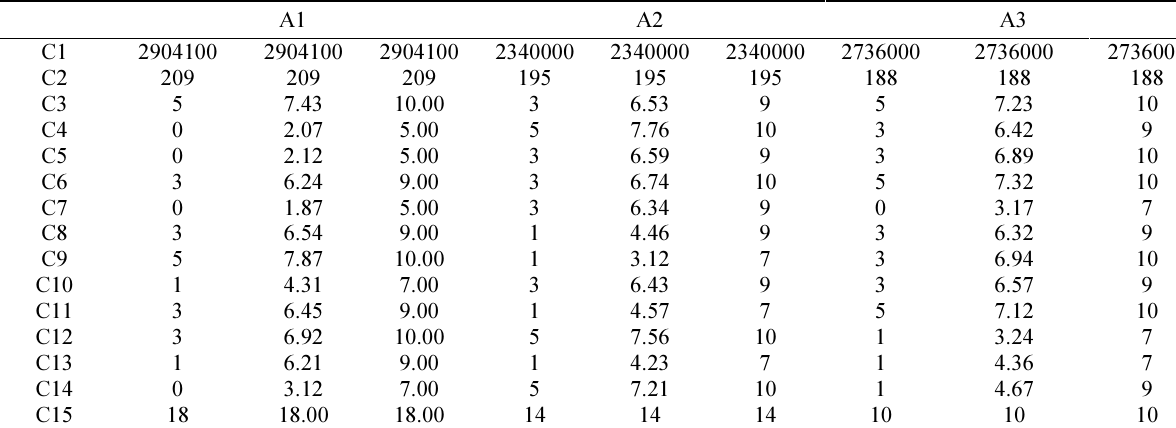
Table 7. Aggregated fuzzy performance ratings